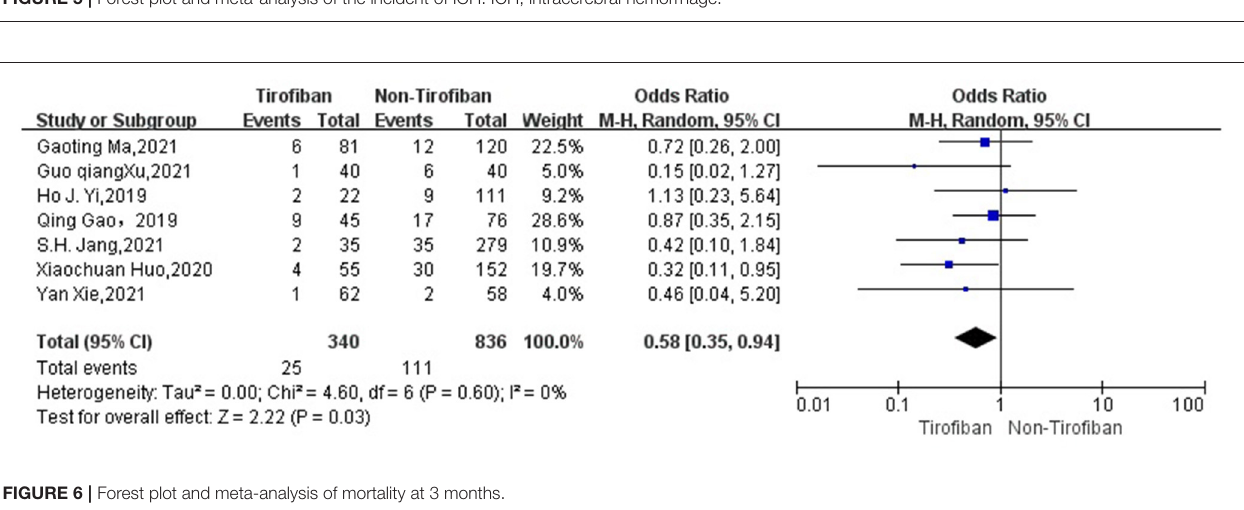
FIGURE 5 | Forest plot and meta-analysis of the incident of ICH. ICH, intracerebral hemorrhage.